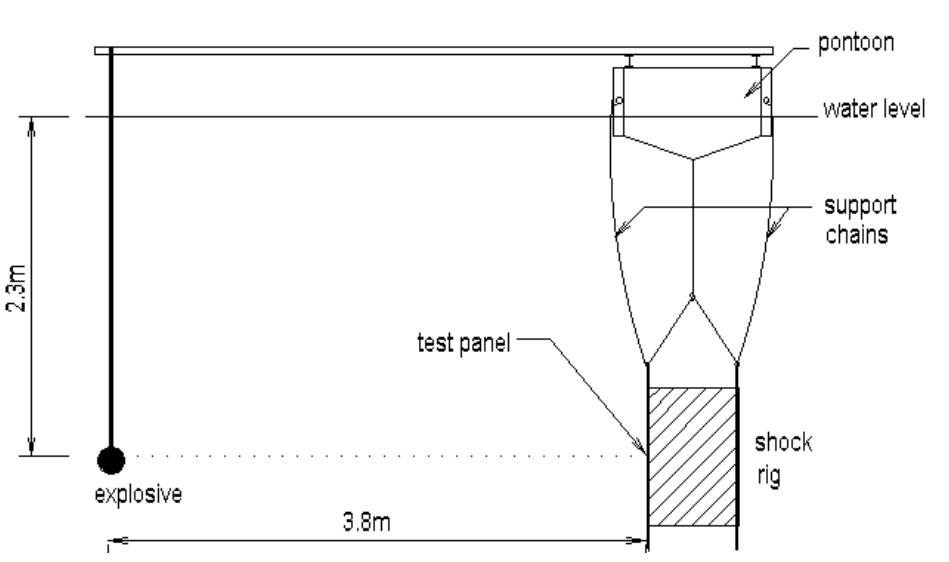
Fig. 6. The charge-structure displacement geometry used in the finite element model for this study. Table 1 LS-DYNA/USA model parameters for dynamic relaxation and choice of fluid material. The resulting